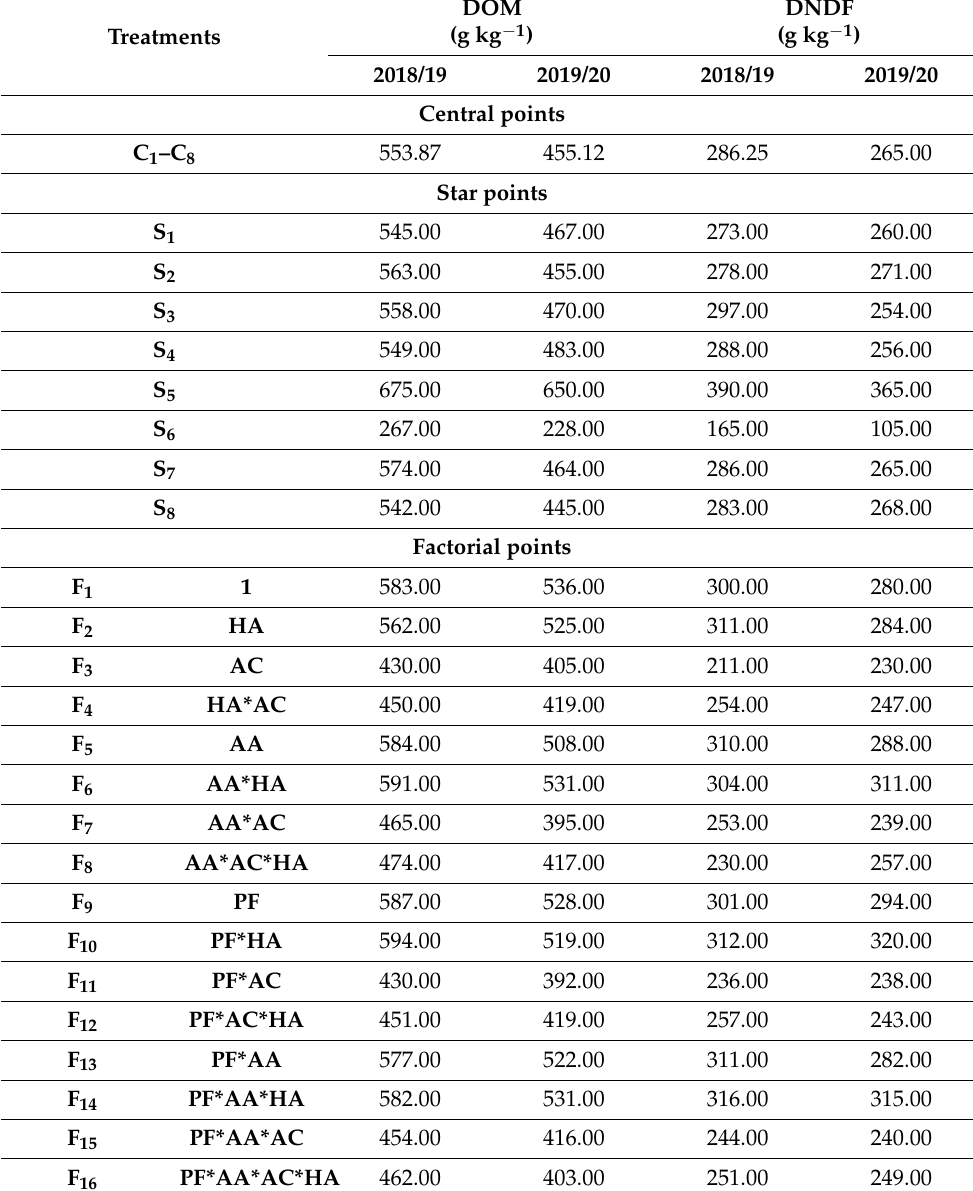
Table 7. Values of degraded organic matter (DOM) and degraded neutral detergent fiber (DNDF), as affected by PF, AA, AC and HA levels and their interactions in 2018/19 and 2019/20.